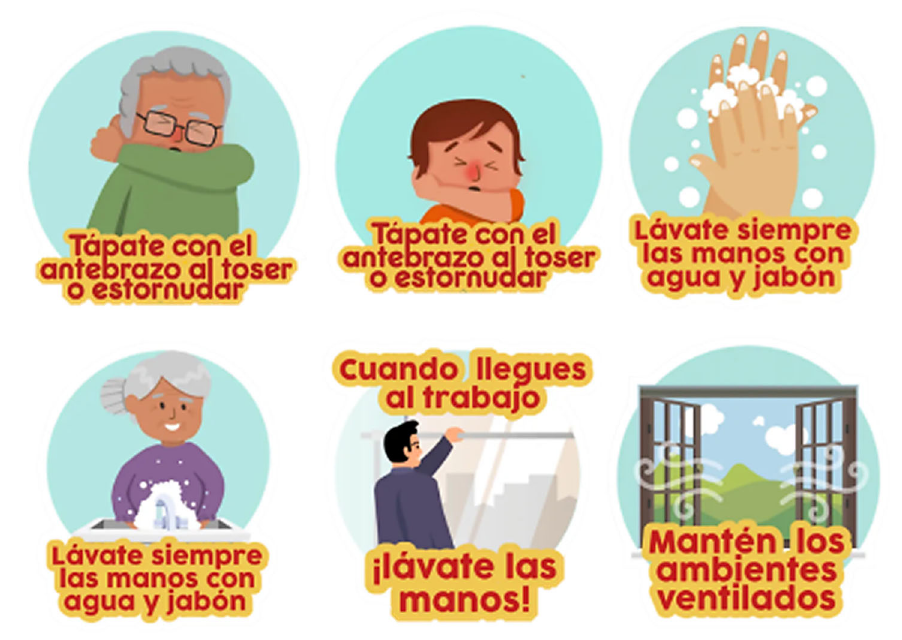
Figure 1. “ Independent ” stickers used in WhatsApp as information tools on hand washing. [Has been repro- duced respecting the intellectual property rights of WhatsApp sticker users].